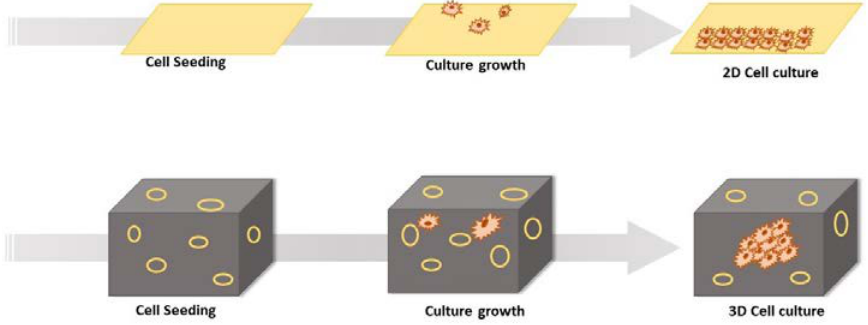
Figure 1. Diagrammatic representation of 2D cell culture and 3D cell culture. Table 1. A comparison of 2D cell culture and 3D cell culture.